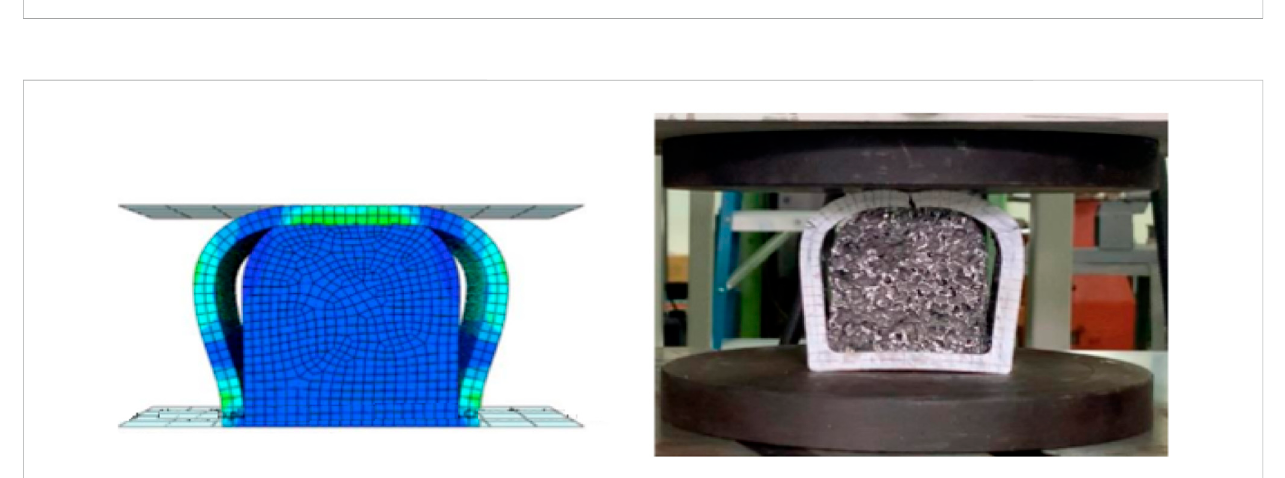
FIGURE 6 Processoffenderspecimenmanufacturing: (A) fenderspecimenfromthecastingprocess (B) CNCprocessoffoam (C) Formedfoam (D) Foam fi lled fender.